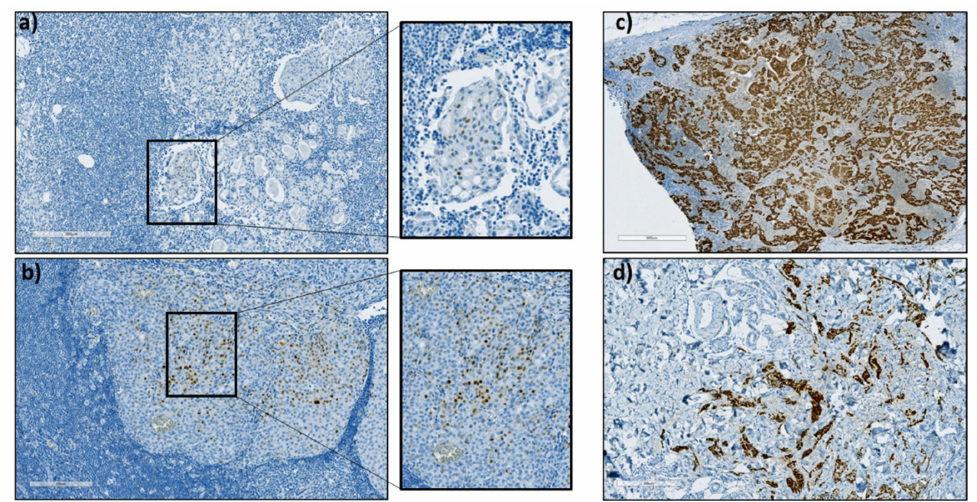
Figure 1. Immunohistochemical staining against PR in LNM specimens showing ( a ) ≥ 1% PR positive tumor cells, ( b ) ≥ 10% PR positive tumor cells, ( c ) 100% PR positive tumor cells and ( d ) a t-CNB derived from a PR positive mamma carcinoma which was used as a positive control.